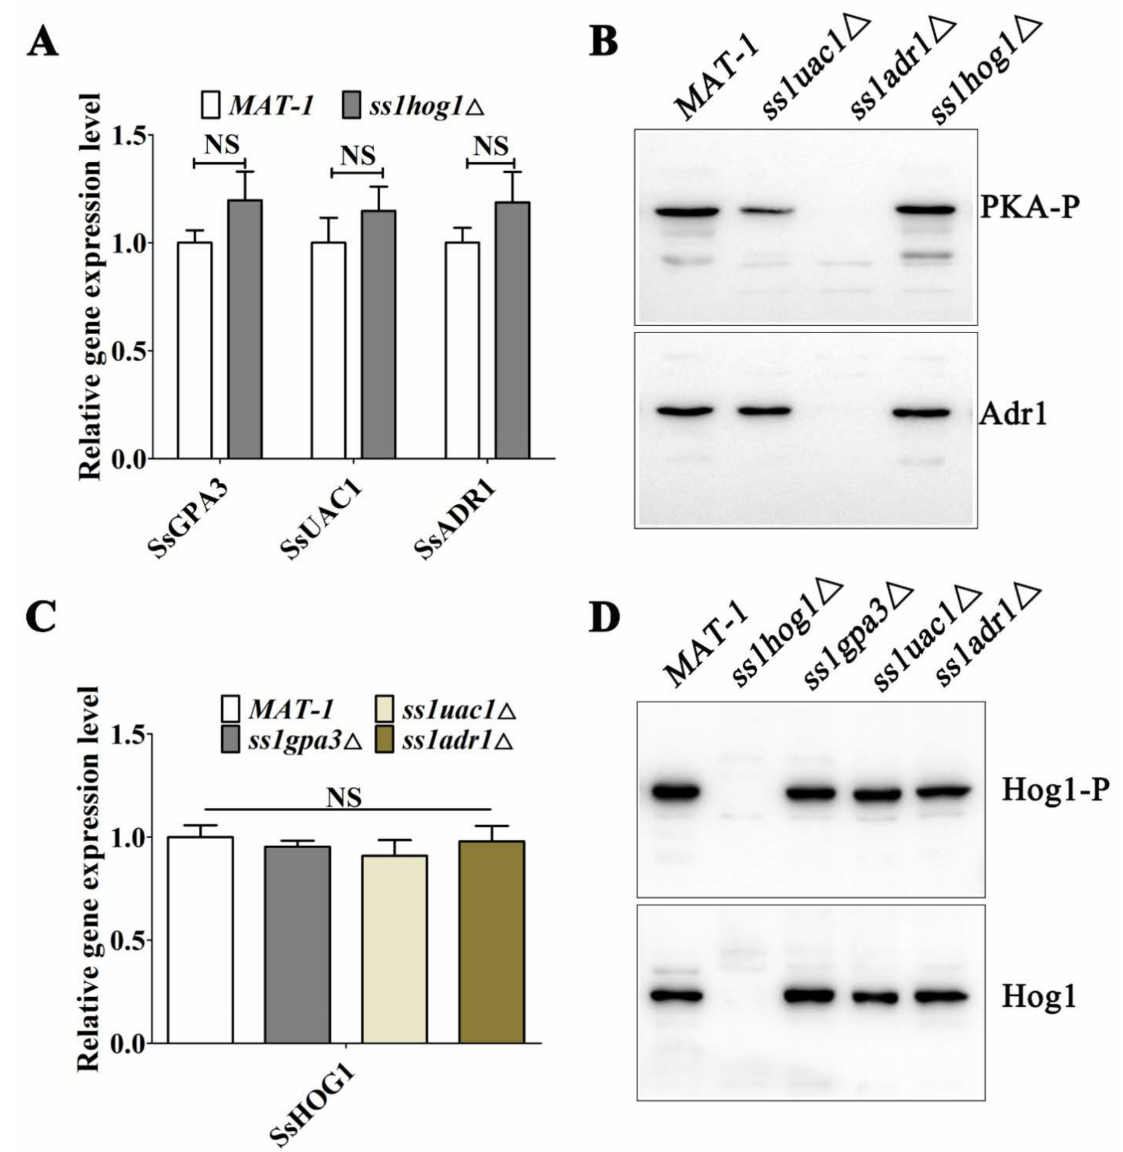
Figure 3. The relationship between MAP kinase Hog1 and cAMP/PKA signaling pathways. ( A ) Tran- scriptional profile of cAMP/PKA-pathway-related genes in MAT-1 and ss1hog1 ∆ . The